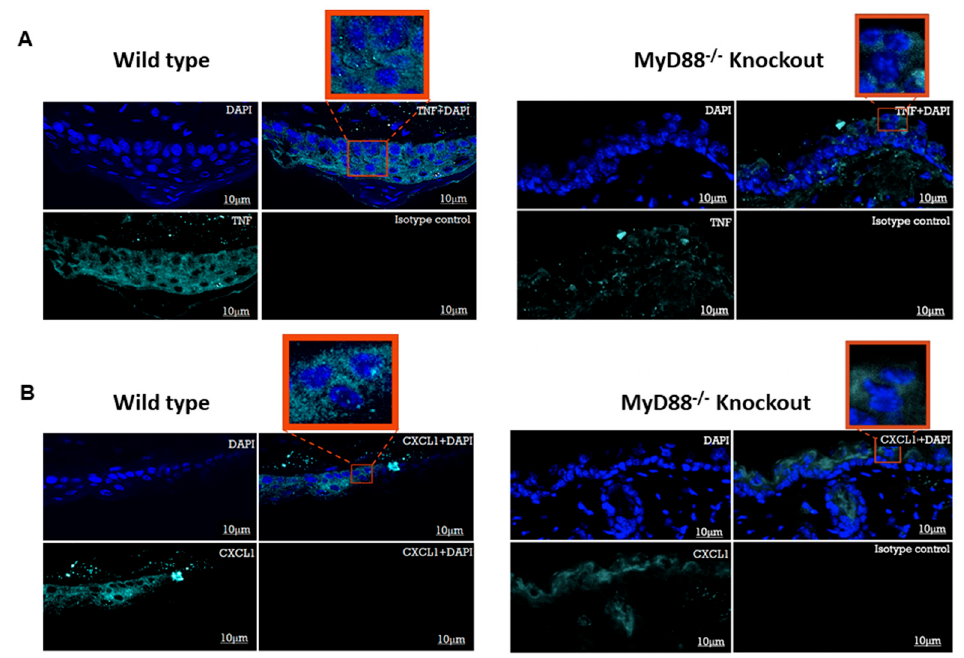
Figure 9. MyD88 knockout mice display a blunted proinflammatory response to poly I:C stimulation: the skins of wild-type mice and MyD88 knockout mice were challenged with poly I:C for a given time point and immunofluorescence imaging was performed on skin tissue sections. A higher mean fluorescence intensity was observed on the skin surface of the wild-type mouse (green (TNF); blue (DAPI)). ( A ). Similarly, a higher mean fluorescence intensity was observed on the skin surface of the wild-type mouse (green (CXCL1); blue (DAPI)) ( B ). (N = 8 mice per group in total (two independent experiments with n = 4 animals/group). Bar = 10 µm).